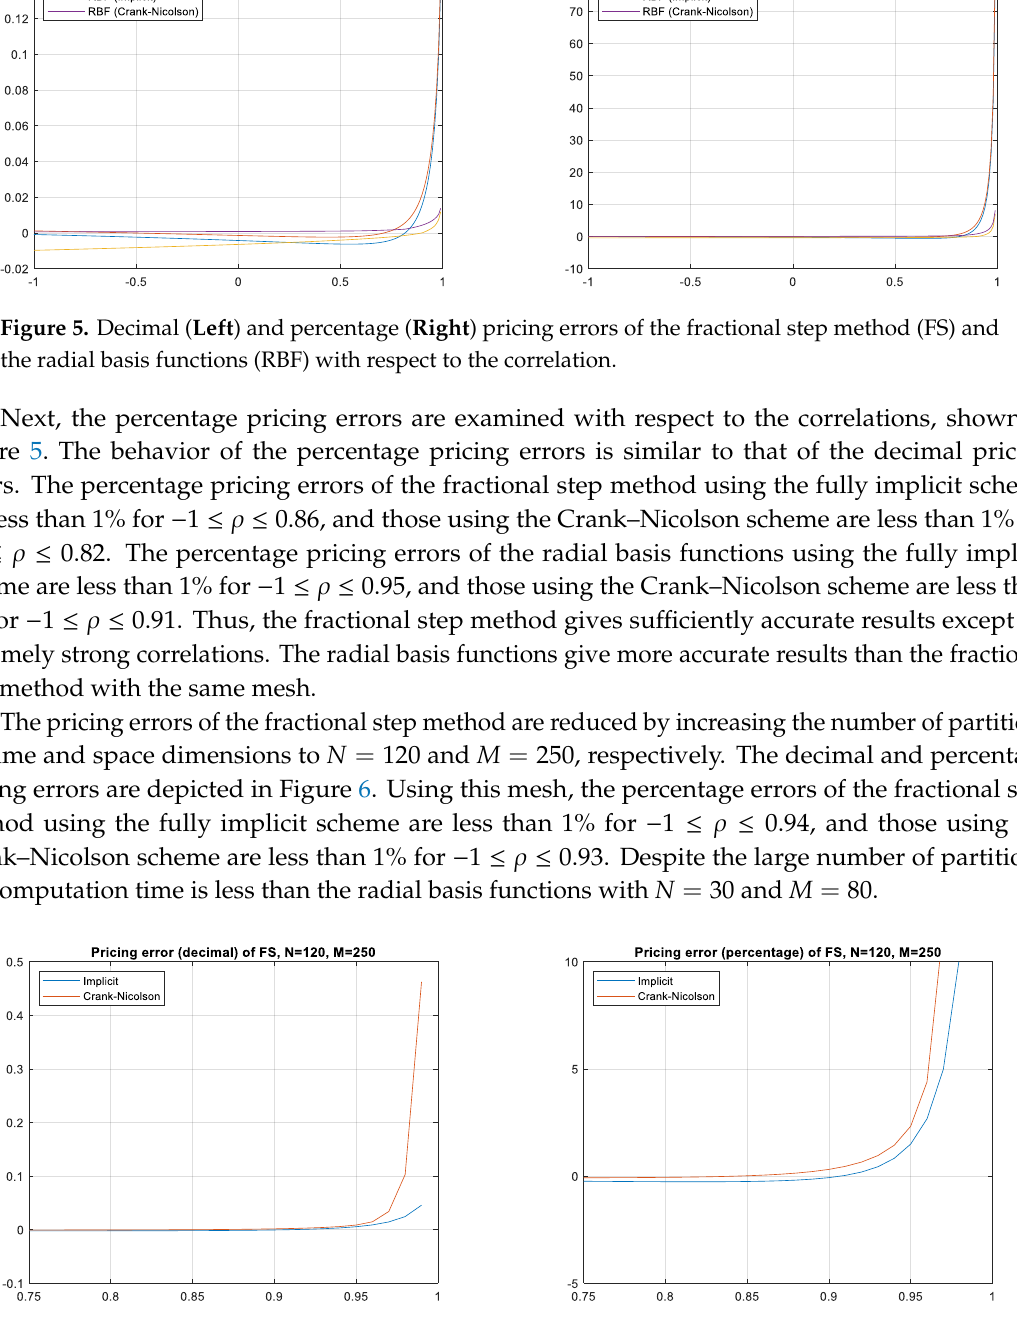
Figure 6. Percentage pricing errors of the fractional step method (FS) with a finer mesh, N = 120 and M = 250 with respect to the strong correlation.